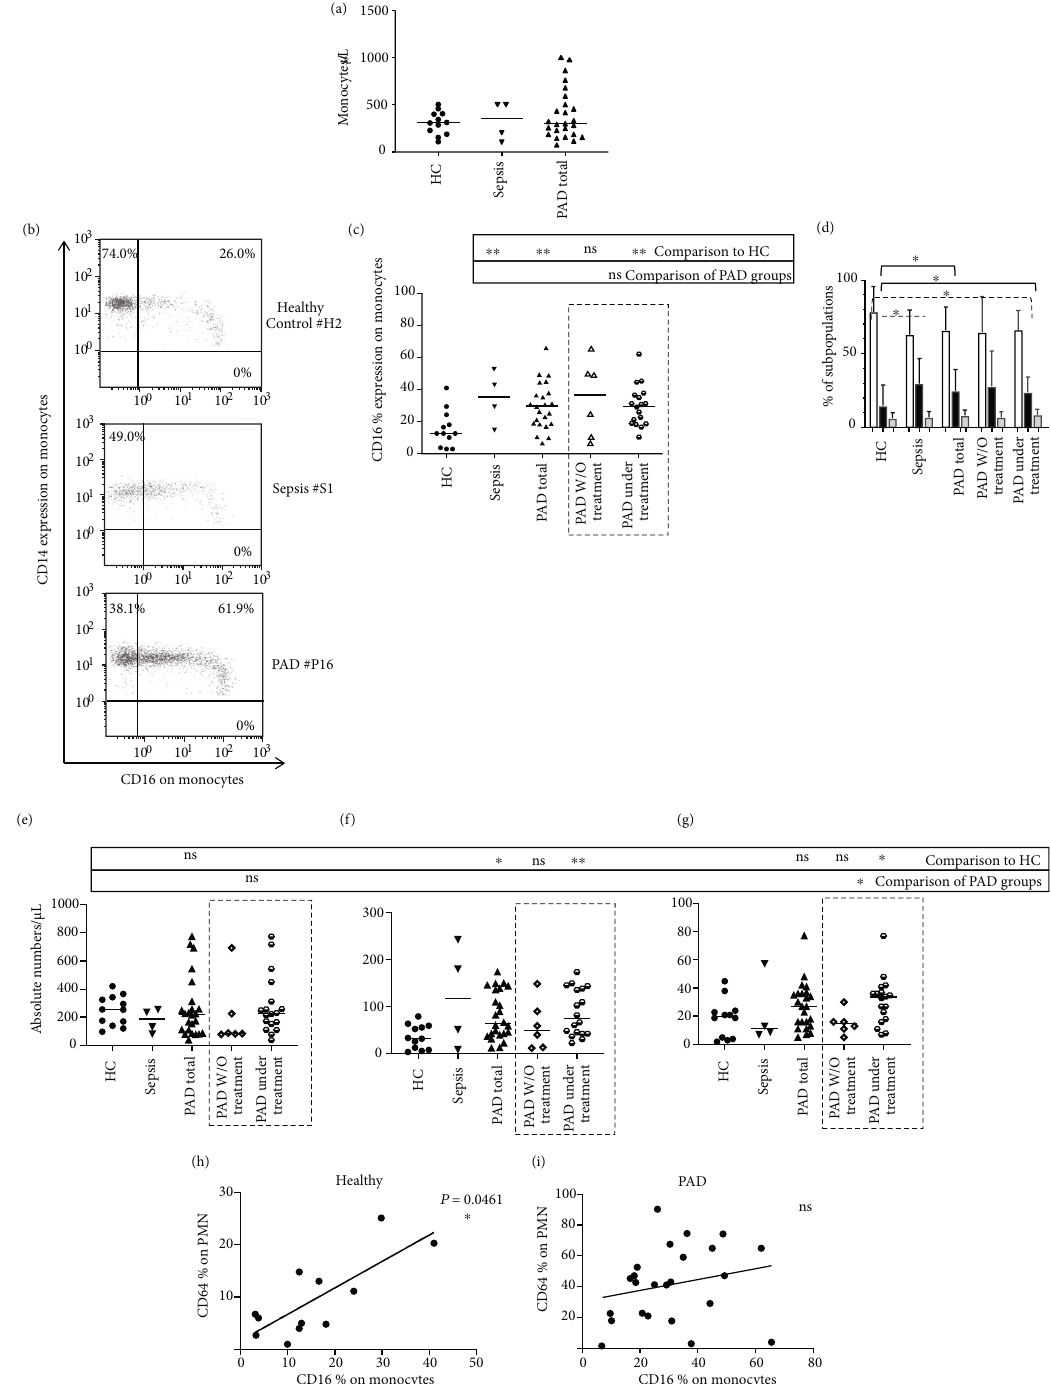
Figure 2: (a) Monocyte absolute numbers (per μ L) of whole peripheral blood of the patients and controls of the study. (b) Representative dot plots of CD16 expression on whole-blood monocytes at basal state. (c) CD16 percentile expression on monocytes of the patients and controls of the study. (d) Percentages of classical, intermediate, and non-classical subpopulations within the monocyte population in whole-blood basal state condition, for the patients and controls of the study: White columns represent classical monocytes, black columns the intermediate monocytes, and grey columns the non-classical monocytes. (e) Absolute numbers of classical, (f) intermediate, (g) and non- classical monocytes. (h) Correlation of CD64 percentage of expression on PMN to CD16 percentage of expression on monocytes on healthy controls and (i) in PAD patients. Statistical analyses were performed by the Mann – Whitney U test and Spearman correlation analysis; ∗ p < 0 : 05 ; ∗∗ p < 0 : 01 ; ns, not signi fi